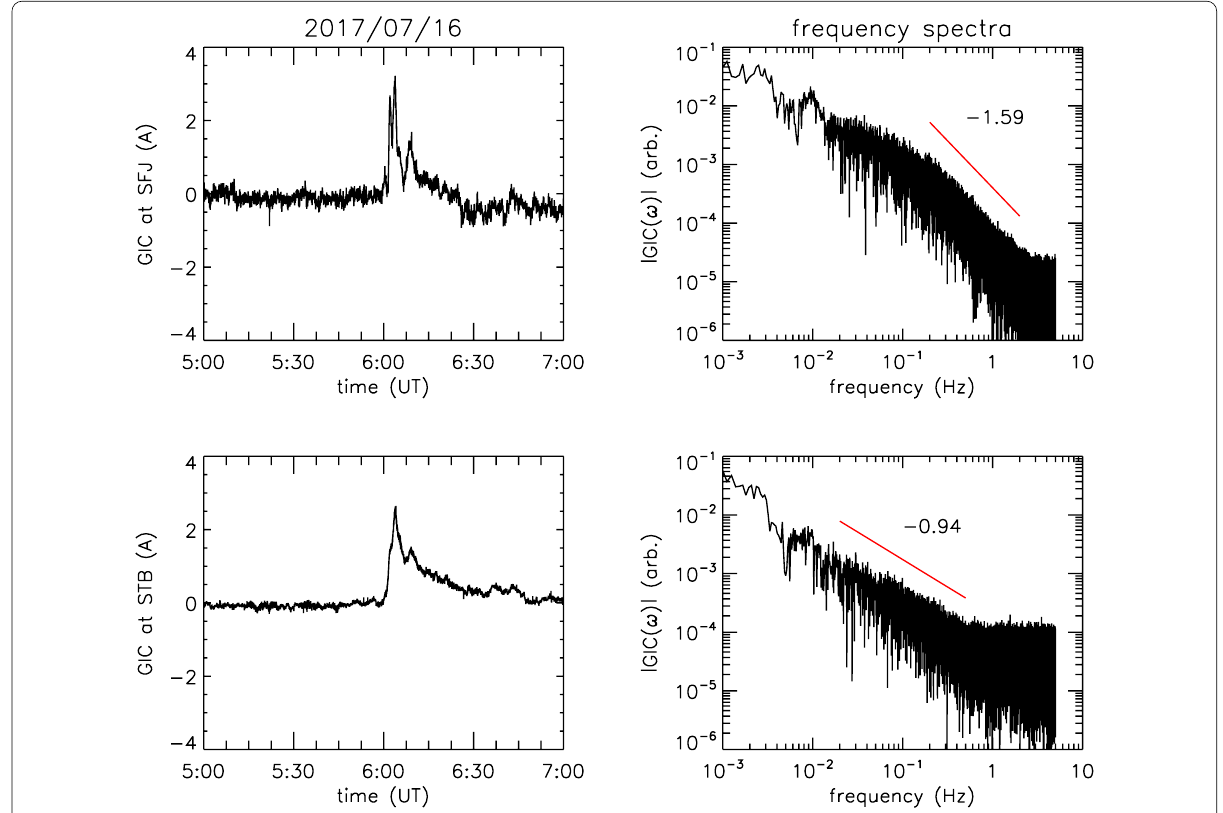
Fig. 7 0.1-s data of GICs at SFJ and STB of the 16 July 2017 SSC and their frequency